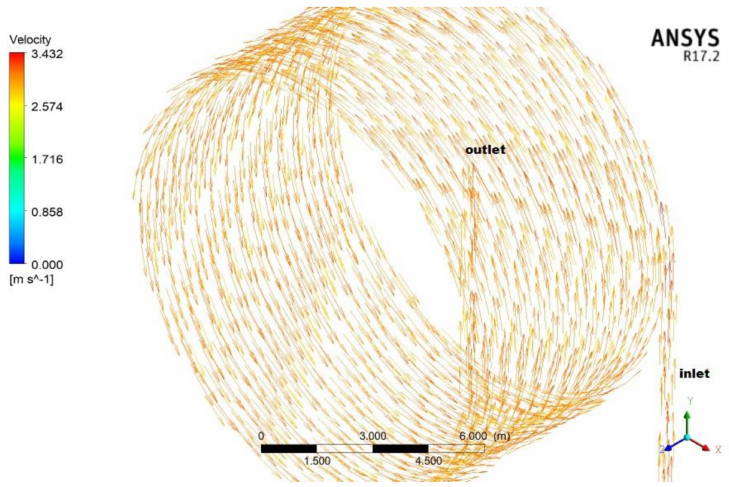
Figure 11. Vector velocity field in the coil obtained in